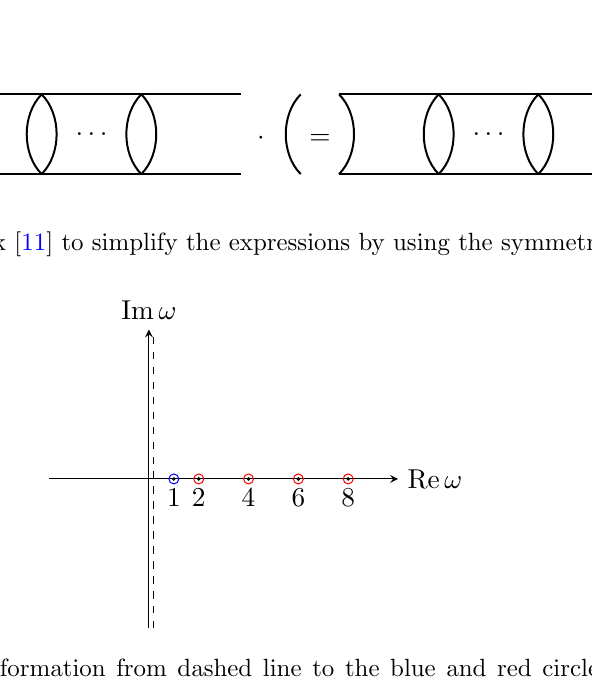
Figure 14. Contour deformation from dashed line to the blue and red circles surrounding the poles on the positive real